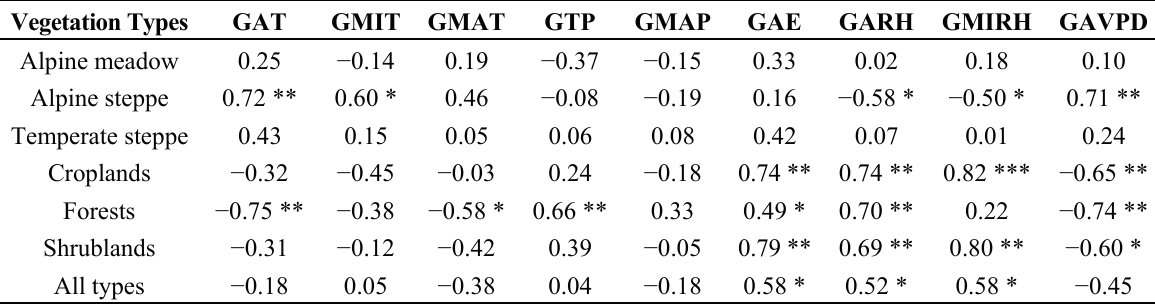
Table 2. Correlation coefficients for the growing season maximum enhanced index (MEVI) with the growing season average temperature (GAT), minimum temperature (GMIT), maximum temperature (GMAT), total precipitation (GTP), maximum precipitation (GMAP), average vapor pressure (GAE), average relative humidity (GARH), minimum relative humidity (GMIRH) and average vapor pressure deficit (GAVPD) from 2000 to 2012 at 81 meteorological stations on the Tibetan Plateau.